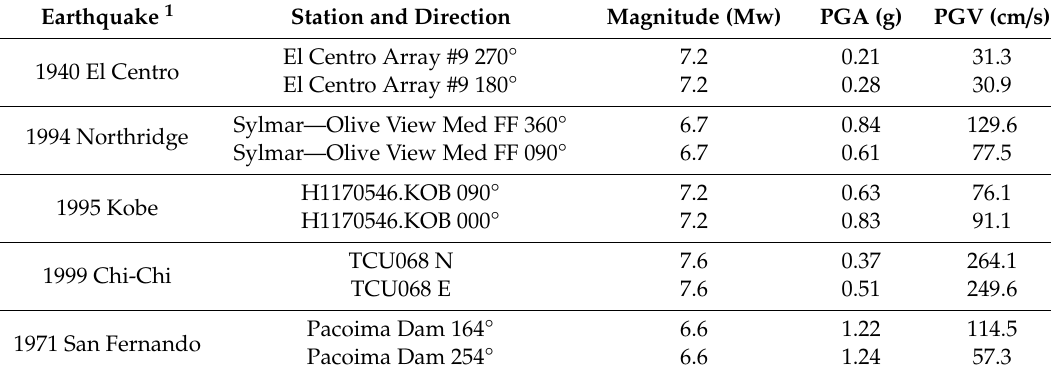
Table 3. Characteristics of the selected earthquake